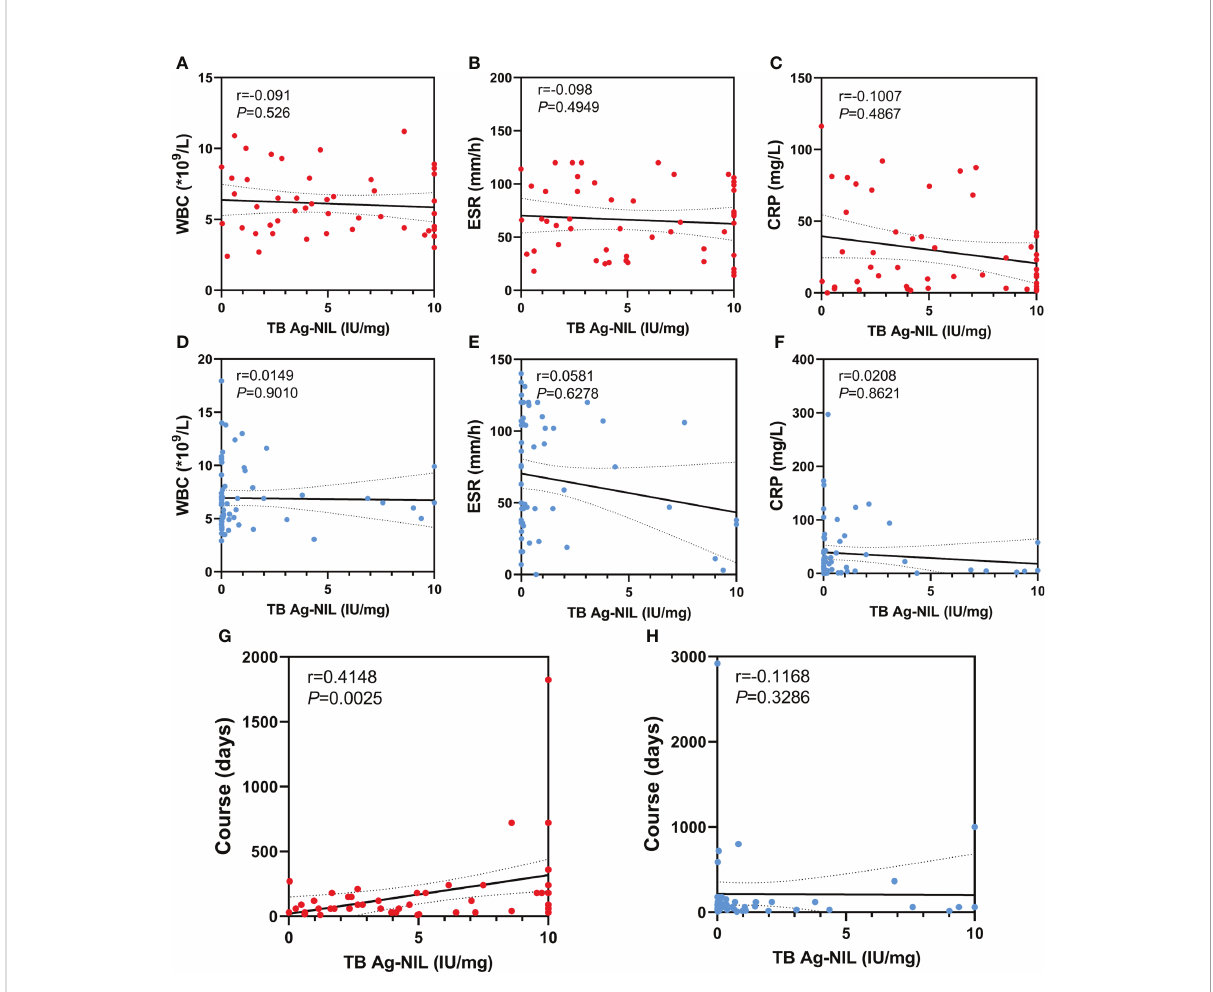
FIGURE 2 Correlation analysis between QFT-GIT and other indication: The red dots represent TB patients and the blue dots represent NTB patients. (A, D) Correlation analysis between TB Ag-Nil and WBC in TB patients or NTB patients; (B, E) Correlation analysis between TB Ag-Nil and ESR in TB patients or NTB patients; (C, F) Correlation analysis between TB Ag-Nil and CRP in TB patients or NTB patients; (G, H) Correlation analysis between TB Ag-Nil and course in TB patients or NTB